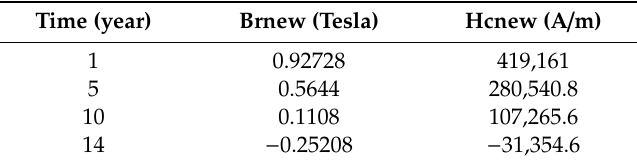
Table 7. Effect of magnet aging on its Br and Hc (150 °C). Table 7. E ff ect of magnet aging on its Br and Hc (150 ◦